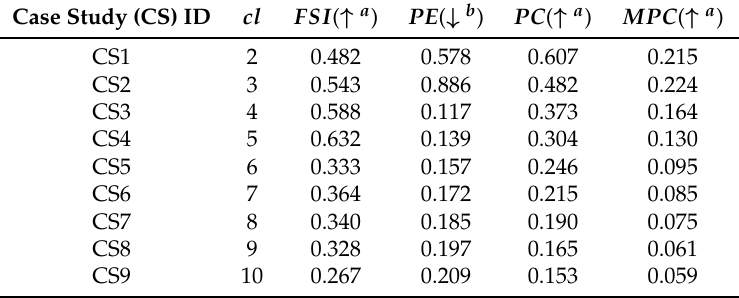
The cluster validity scores for the nine case studies from the scRNA-seq gene expression